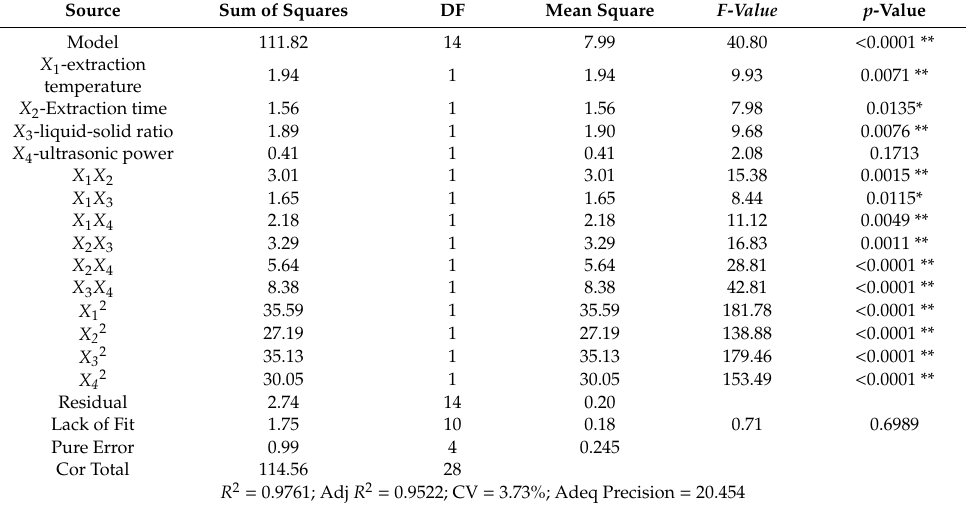
Table 2. The ANOVA results for the response surface quadratic models of AAP